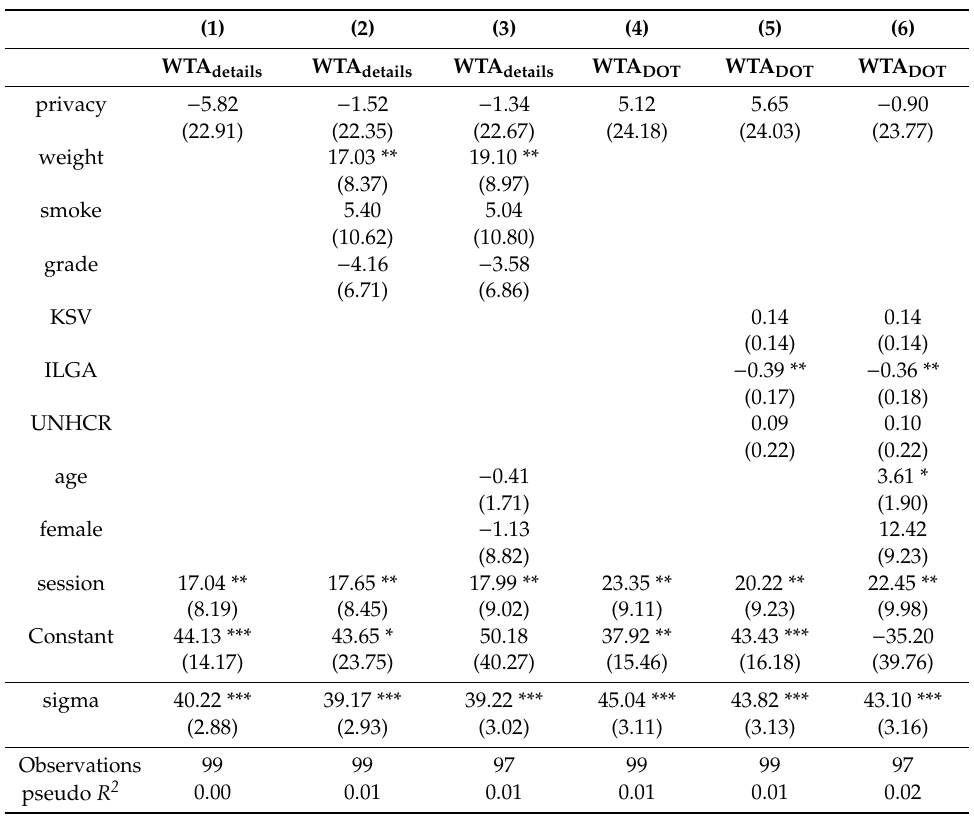
Table A6. Tobit regressions of WTA on self-stated privacy behavior (factor analysis a1, a3, a6, a7) and information at stake.